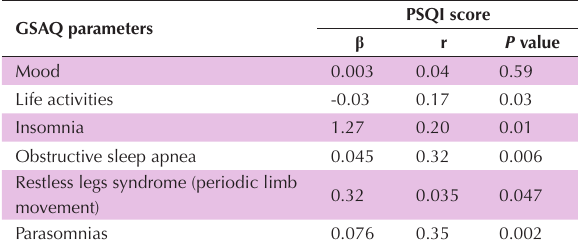
Table 3. Correlation between GSAQ and